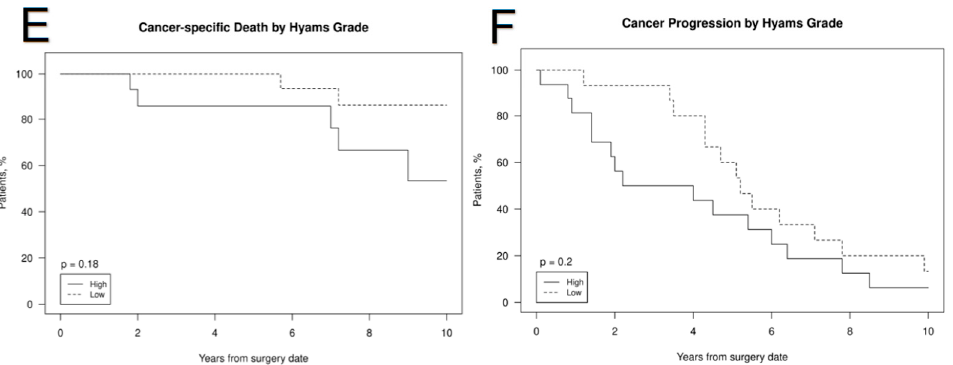
Figure 1. All-cause mortality from date of primary ENB diagnosis in patient with recurrences ( A ), cancer-specific mortality from date of surgery ( B ), cancer progression from date of surgery ( C ), all- cause mortality from date of surgery between HGH and LGH ( D ), cancer-specific mortality from date of surgery between HGH and LGH ( E ), cancer progression from date of surgery between HGH and LGH ( F ).